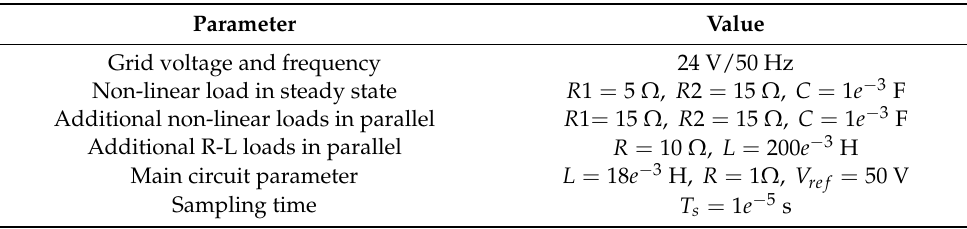
Table 1. System parameters in